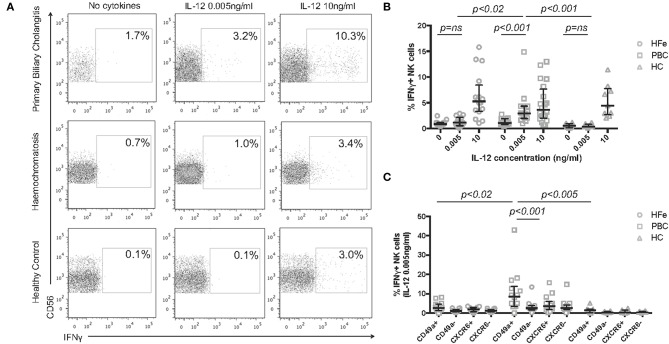
(A) Representative flow cytometry plots for each patient group showing the gating strategy for IFNγ+ NK cells, following gating on CD3-CD56+ NK cells, post stimulation with increasing concentrations of IL-12 for 12 h. (B) The frequency of IFNγ+ NK cells from the peripheral blood of individuals with HFe (n = 14–16), PBC (n = 14–20), and HC (n = 8–9) following stimulation with increasing concentrations of IL-12 for 12 h. (C) The frequency of IFNγ+ NK cells within the CD49a+, CD49a-, CXCR6+, and CXCR6- NK cell populations from the peripheral blood of individuals with HFe (n = 14), PBC (n = 14), and HC (n = 8) following stimulation with IL-12 0.005 ng/ml for 12 h. Dot plots show individual values, the median and interquartile range. Patient groups were compared using the Kruskal-Wallis test with Dunn's multiple comparison test. The Wilcoxon matched pairs test was used to compare IL-12 concentrations and NK cell subpopulations within the same patient group.